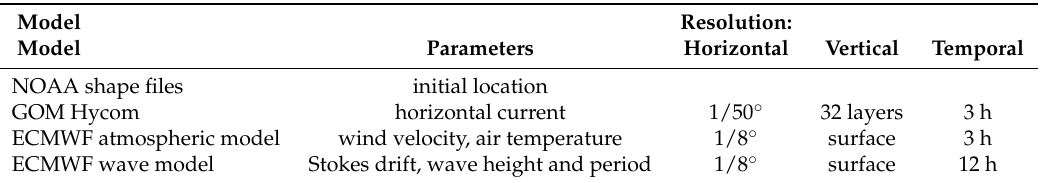
Table 1. Summary of Metocean forcing used in the